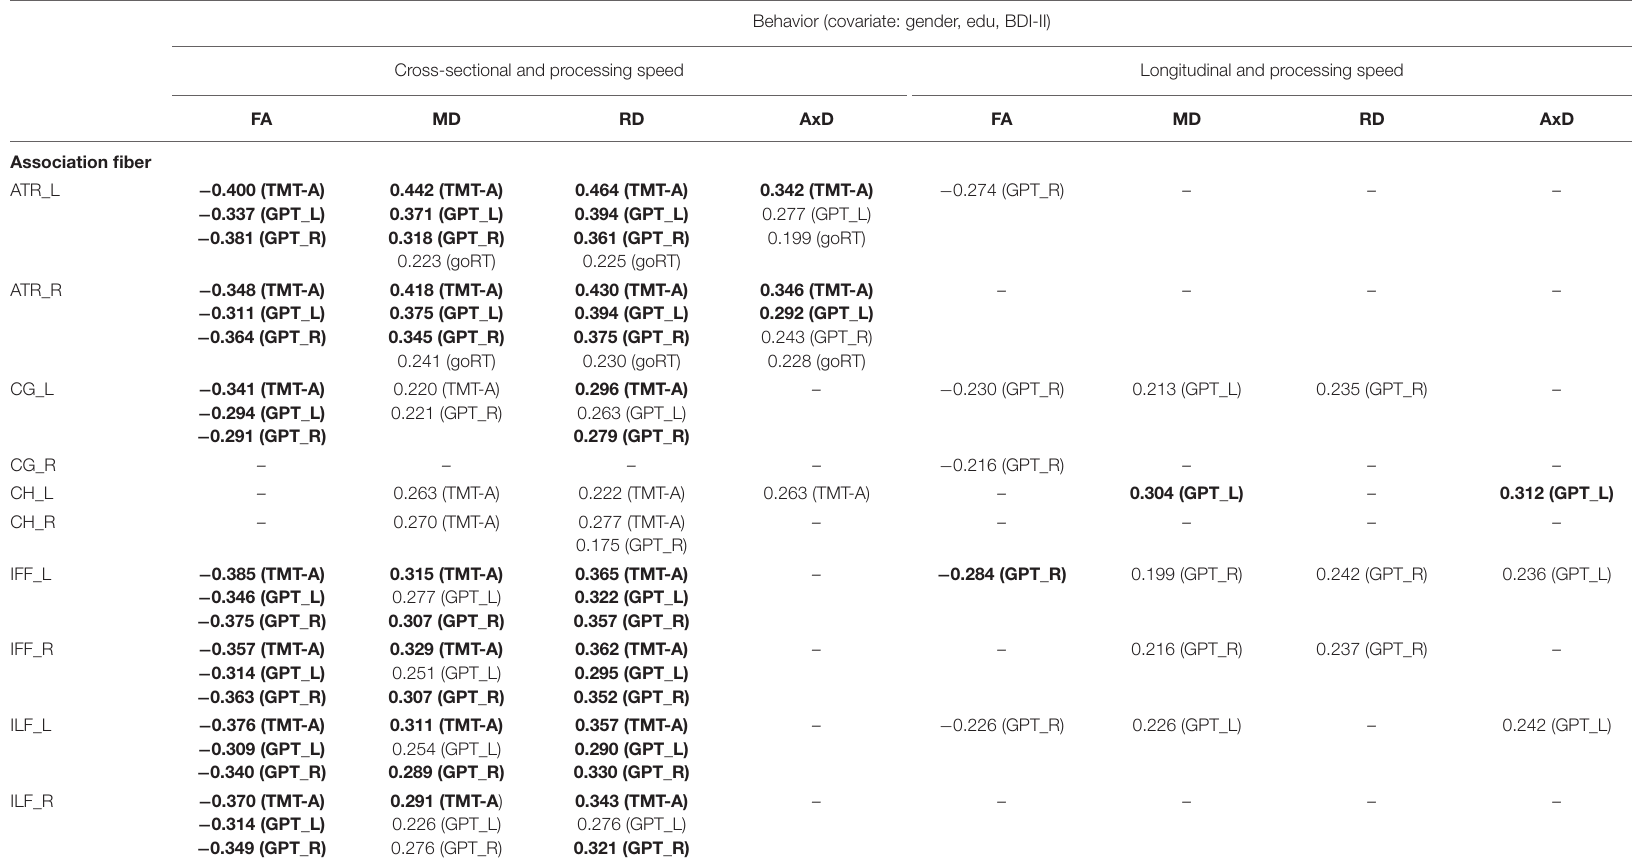
TABLE 4 | The significant Pearson correlation r values for processing speed in relation to DTI measures (FA, MD, RD, and AxD) for cross-sectional and longitudinal ratio